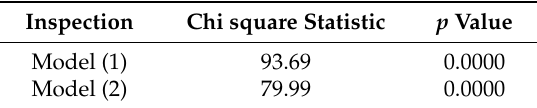
Table 6. Hausman Test.